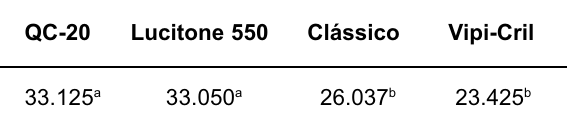
Different letters indicate statistically significant difference (p<0.05).